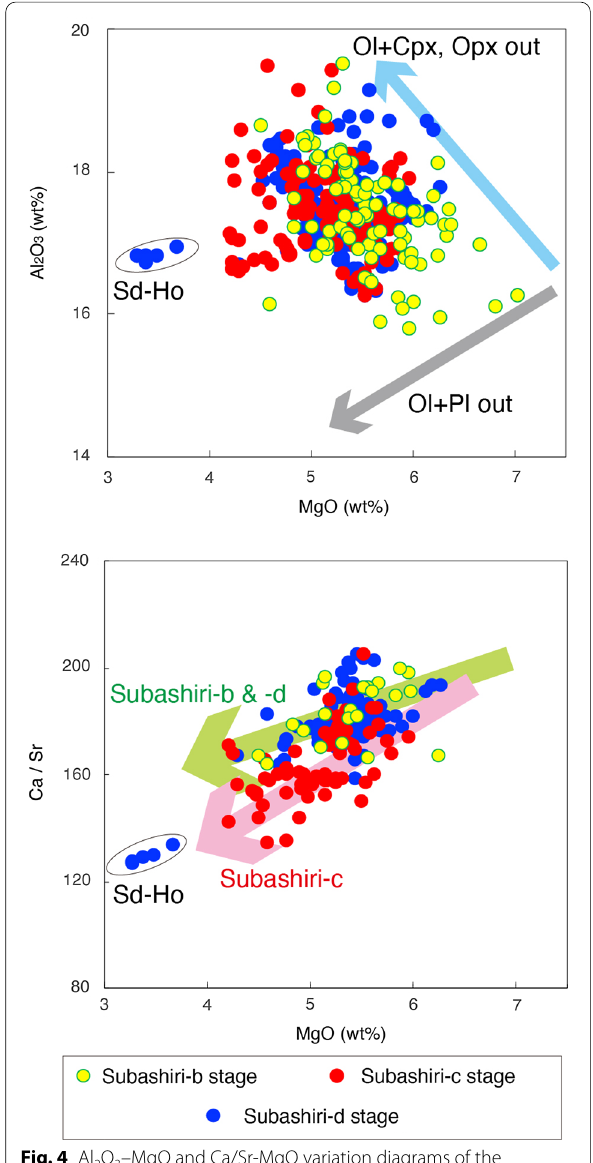
Fig. 4 Al 2 O 3 –MgO and Ca/Sr-MgO variation diagrams of the Subashiri stage products (Ol, olivine; Cpx, clinopyroxene; Opx, orthopyroxene; Pl,